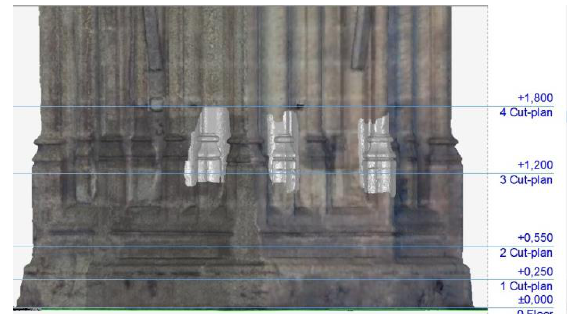
Figure 5. Section comparison